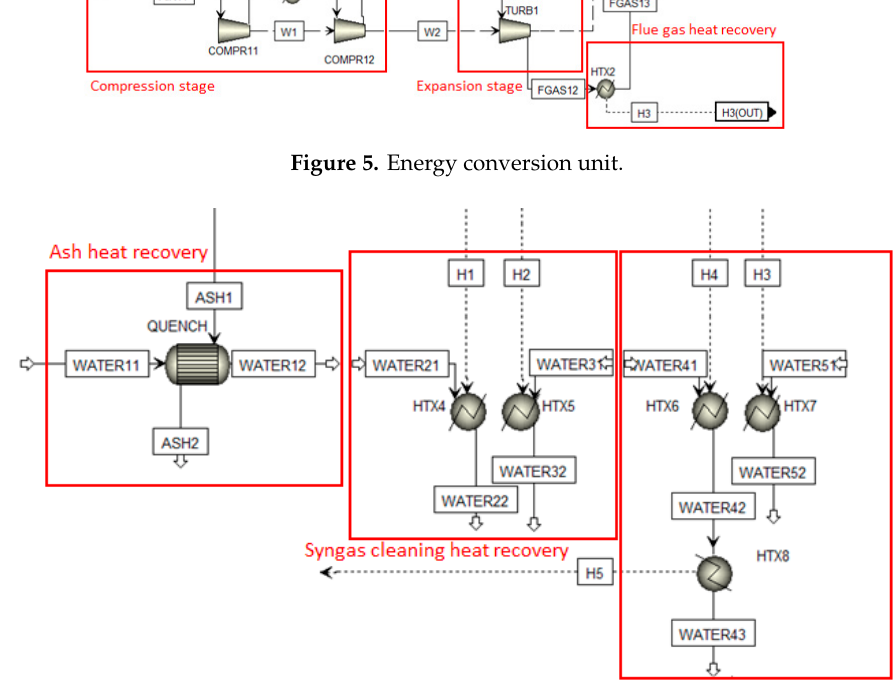
Figure 5. Energy conversion unit. Designs 2020 , 4 , x FOR PEER REVIEW